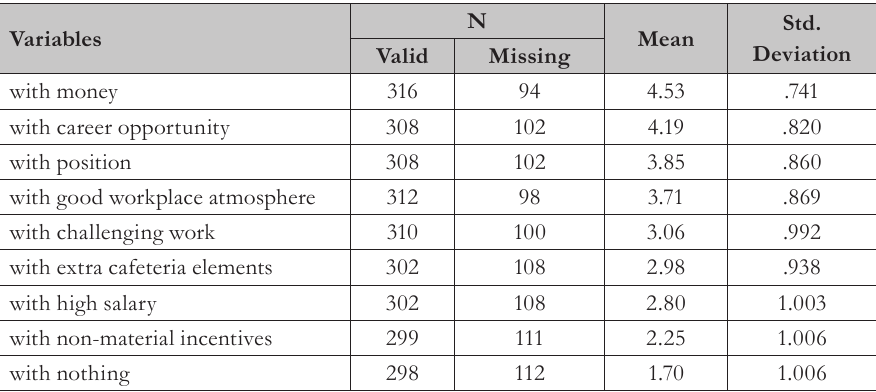
Tab.7 - Incentives for the young adults (N. %) Source: authors’